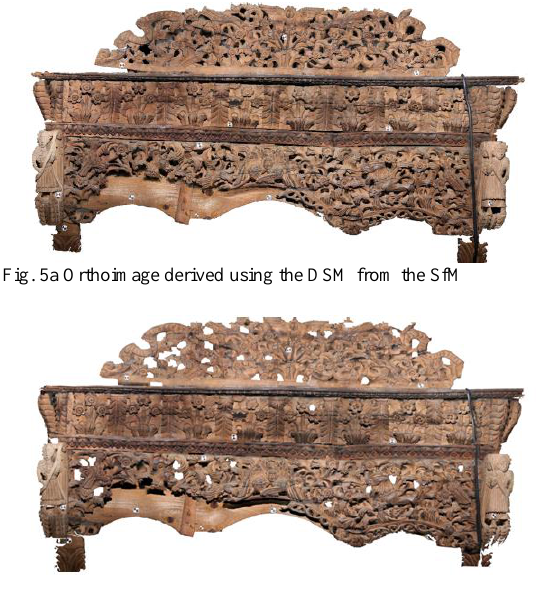
Fig. 5b Orthoimage derived using the DSM from scanning